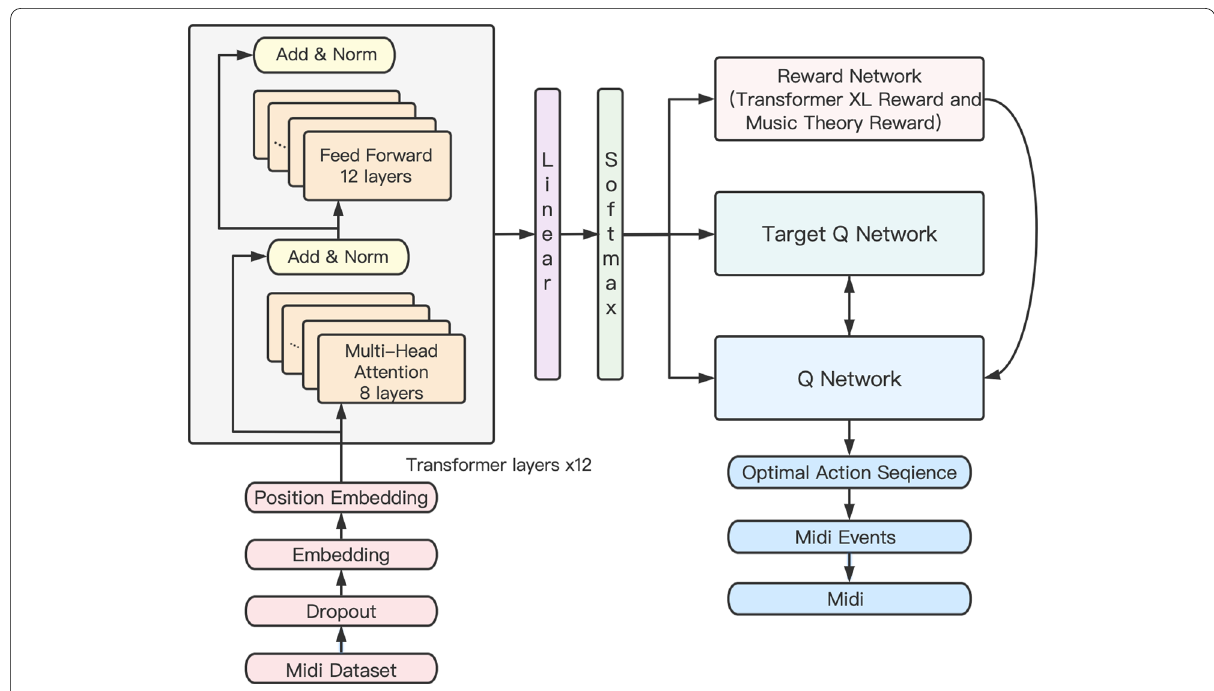
Fig. 2 Transformer-XL